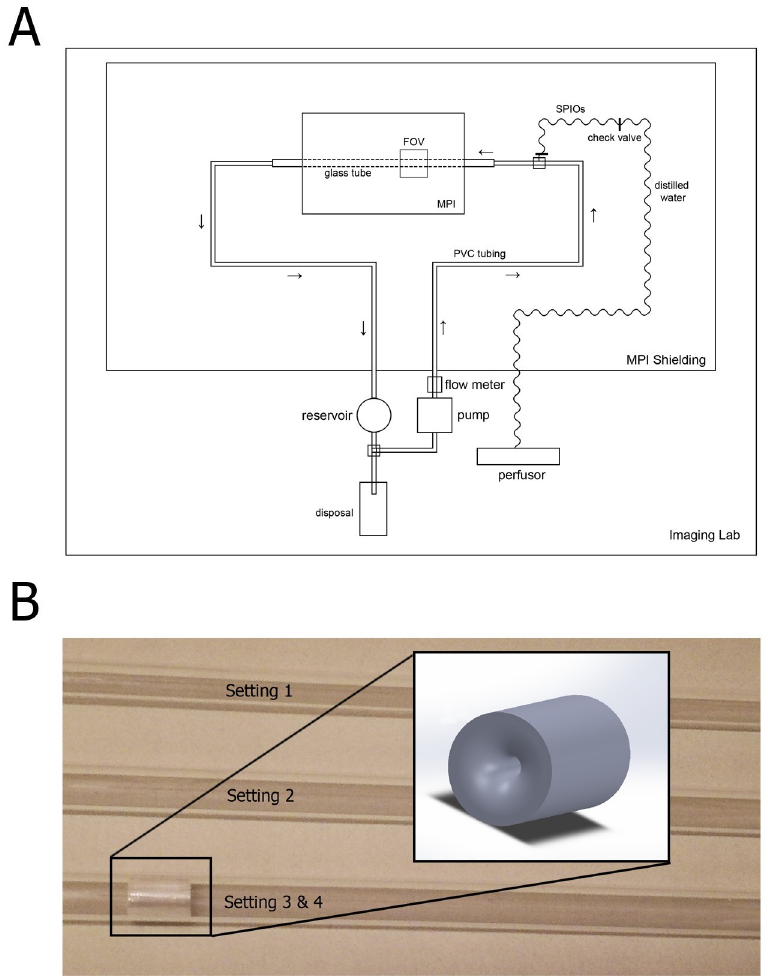
Fig 2. Experimental setup and stenosis model. (A) Glass tubes with an inner diameter of 4, 6 and 10 mm were used as imaging phantoms and connected to a centrifugal pump via dedicated tubes to establish a closed water circuit. An ultrasonic flow-meter was used to adjust the flow rates in order to obtain coronary-specific velocities inside the glass tubes. Standardised SPION-boluses were then injected using a perfusor and visualised by a preclinical MPI scanner. (B) : In experiment B four specific flow settings were investigated by using MPI to compute the coronary flow reserve in a simulated stenotic vessel (setting 1: 4 mm diameter, no stenosis; setting 2: 6 mm diameter, no stenosis; setting 3: 6 mm diameter, stenosis; setting 4: 6 mm diameter, stenosis, doubled flow rate as in